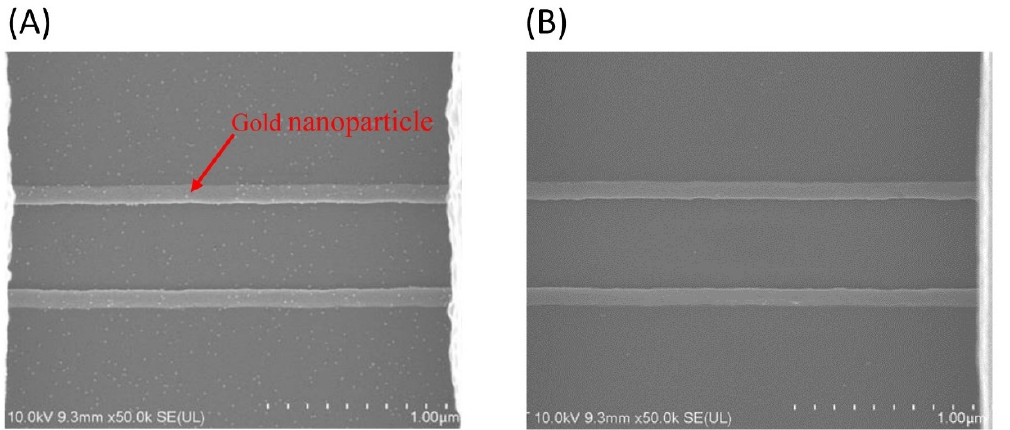
Figure 1. SEM images of the poly-Si nanowire (NW) following surface modification. Surface modification of the pSNWFET device was observed through SEM following the addition of gold nanoparticle-conjugated IgG, as described in the Methods section. ( A ) Surface treated with 3-aminopropyltriethoxysilane (APTES), glutaraldehyde, and PSGL-1 peptide. Following protein tyrosine sulfation (PTS) on the tyrosine residue of PSGL-1 peptide with phenol sulfotransferase– tyrosylprotein sulfotransferase (PST–TPST) coupled enzyme assay, anti-sulfotyrosine antibody and gold nanoparticle-conjugated IgG were subsequently treated. ( B ) Surface treated with APTES, glutaraldehyde, PSGL-1 peptide, followed by coupled enzyme system treatment without TPST. Anti- sulfotyrosine antibody and gold nanoparticle-conjugated IgG were subsequently treated.